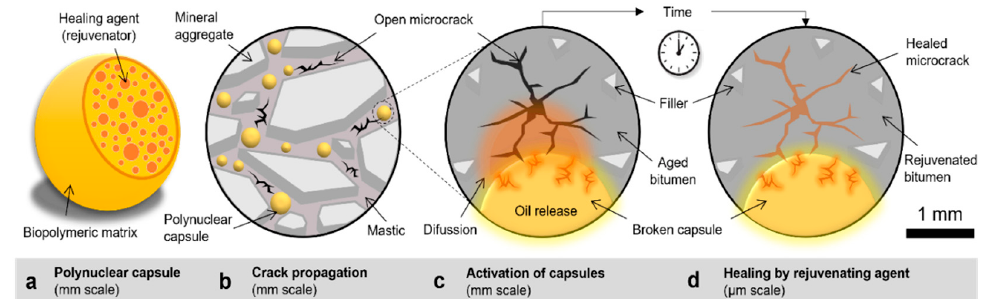
Figure 1. Concept of self-healing in asphalt using encapsulated rejuvenators. ( a ) Polynuclear capsules are spherical particles with the encapsulated material distributed throughout a polymeric porous matrix structure. ( b ) Propagation of microcracks in an asphalt mixture incorporating polynuclear capsules. ( c ) Microcracks reach a polynuclear capsule resulting in their superficial rupture, and so, releasing the encapsulated healing agent (i.e., WCO). ( d ) The healing agent diffuses into the cracked zone with a softening effect on the aged bitumen, sealing the damaged area.